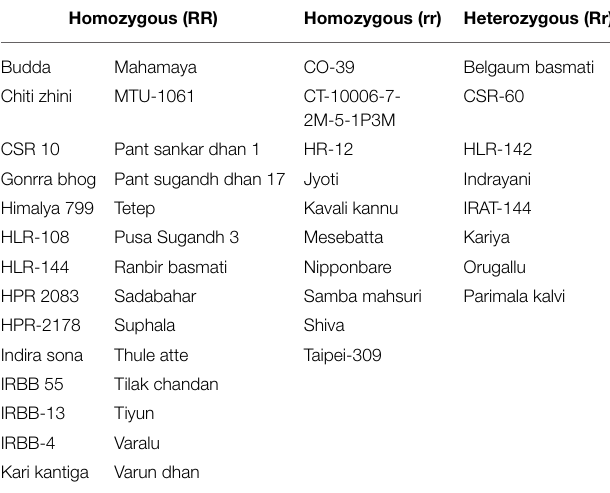
TABLE 5 | List of rice accessions distinguishable based on co-dominant